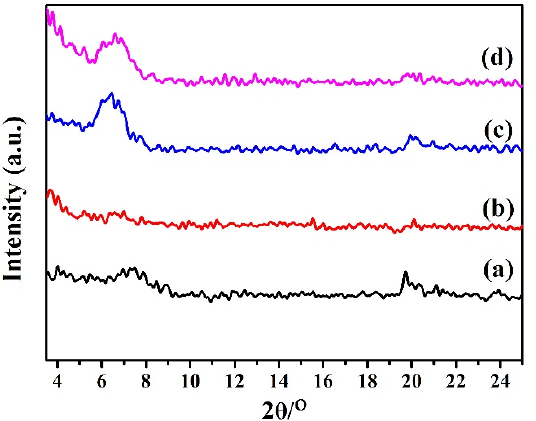
Figure 2. XRD curves of ( a ) bentonite, ( b ) 1Alg-10Bt, ( c ) 1Alg-30Bt, and ( d ) 3Alg-30Bt.